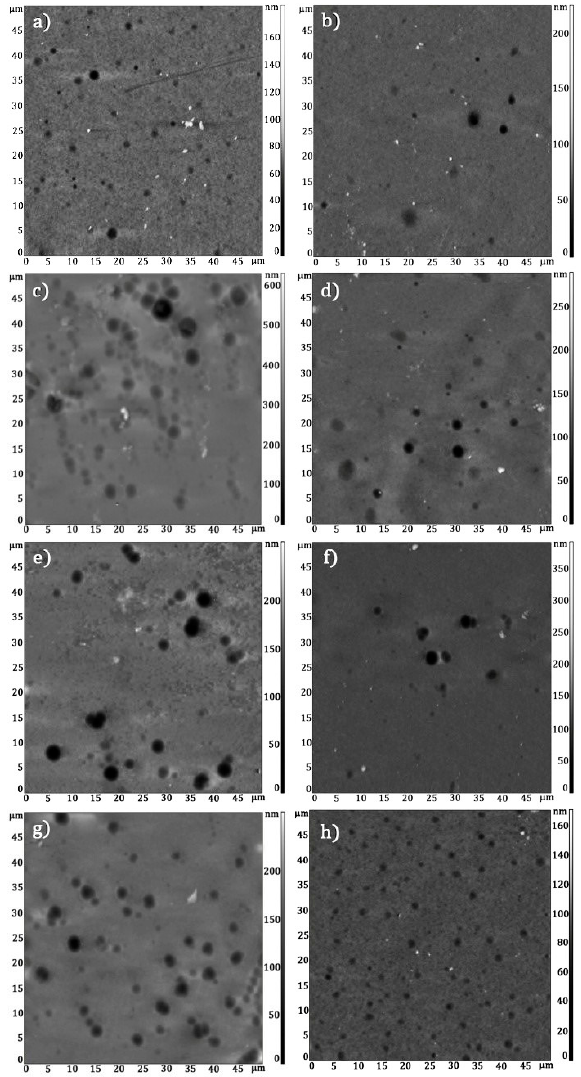
Figure 7. AFM images of first ( a , c , e , g ) and second ( b , d , f , h ) post etched CR-39 detectors when high-power laser pulse irradiates: 5 µ m thick Ag target; 5 µ m thick Al target; 10 µ m thick Ag target; respectively, 10 µ m thick Al target.